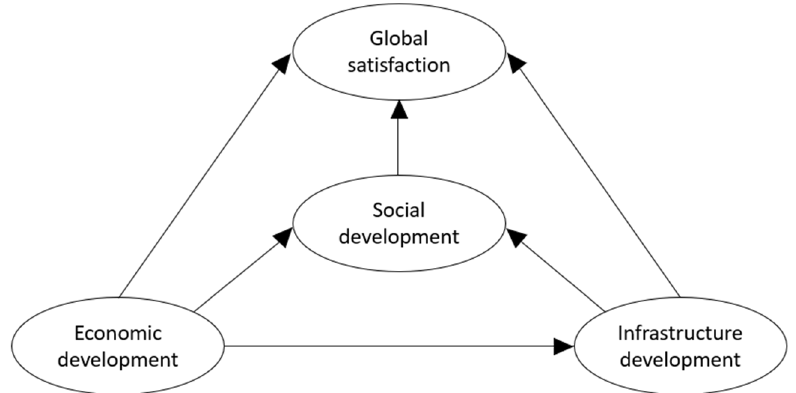
Figure 1. Relationships between constructs.